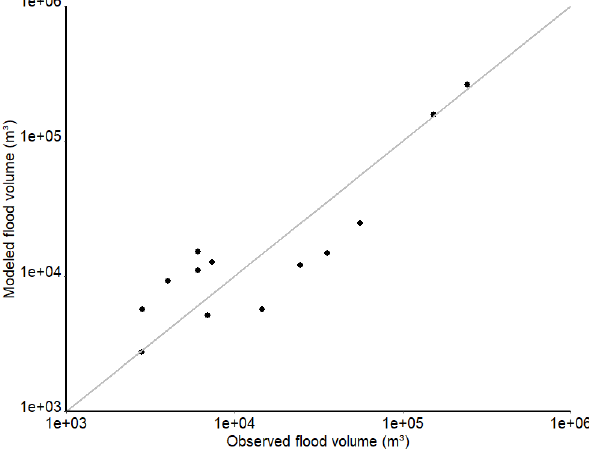
Figure 6. Scatterplot of the flood volumes derived from the ob- served flood extents (observed flood volume, m 3 ) and the flood vol- umes as modeled by Eq. (6) (modeled flood volume, m 3 ), with an adjusted R 2 of 0.76 and a relative RMSE of